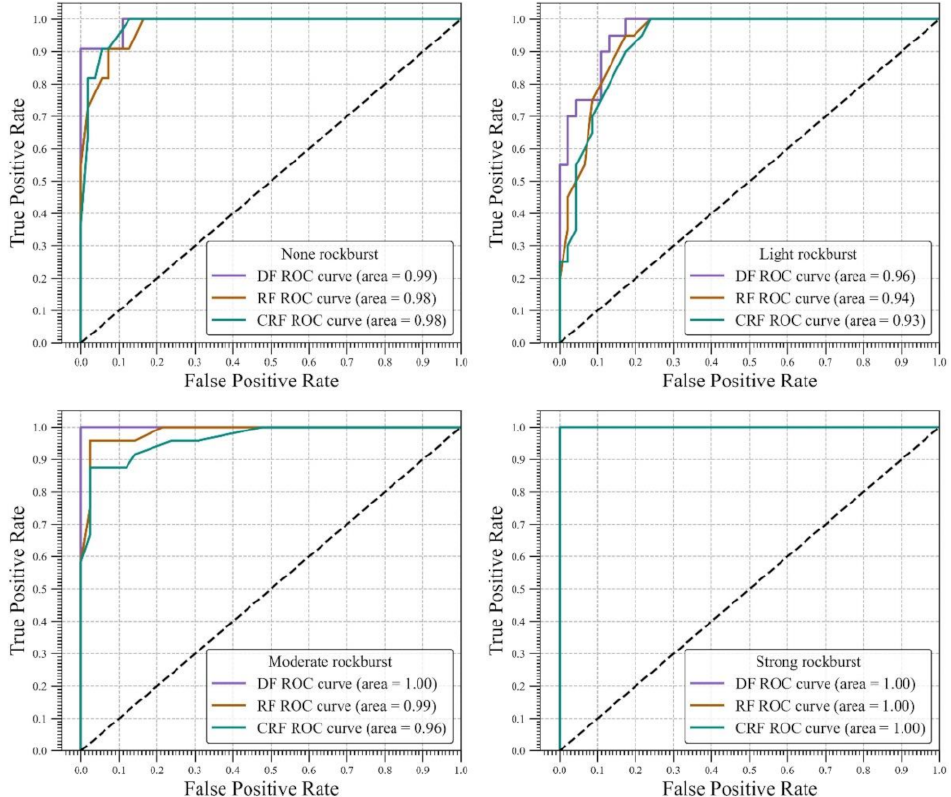
Figure 9. Model performance comparison in each rockburst by ROC curve.